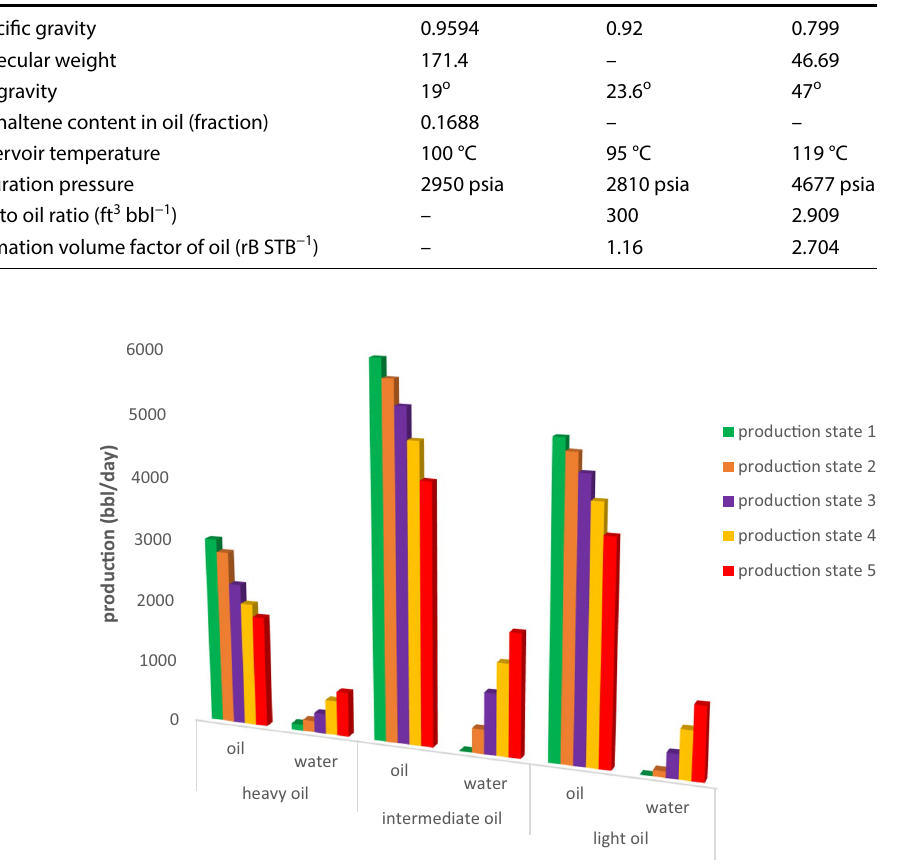
Table 2 Properties of the modelled oil